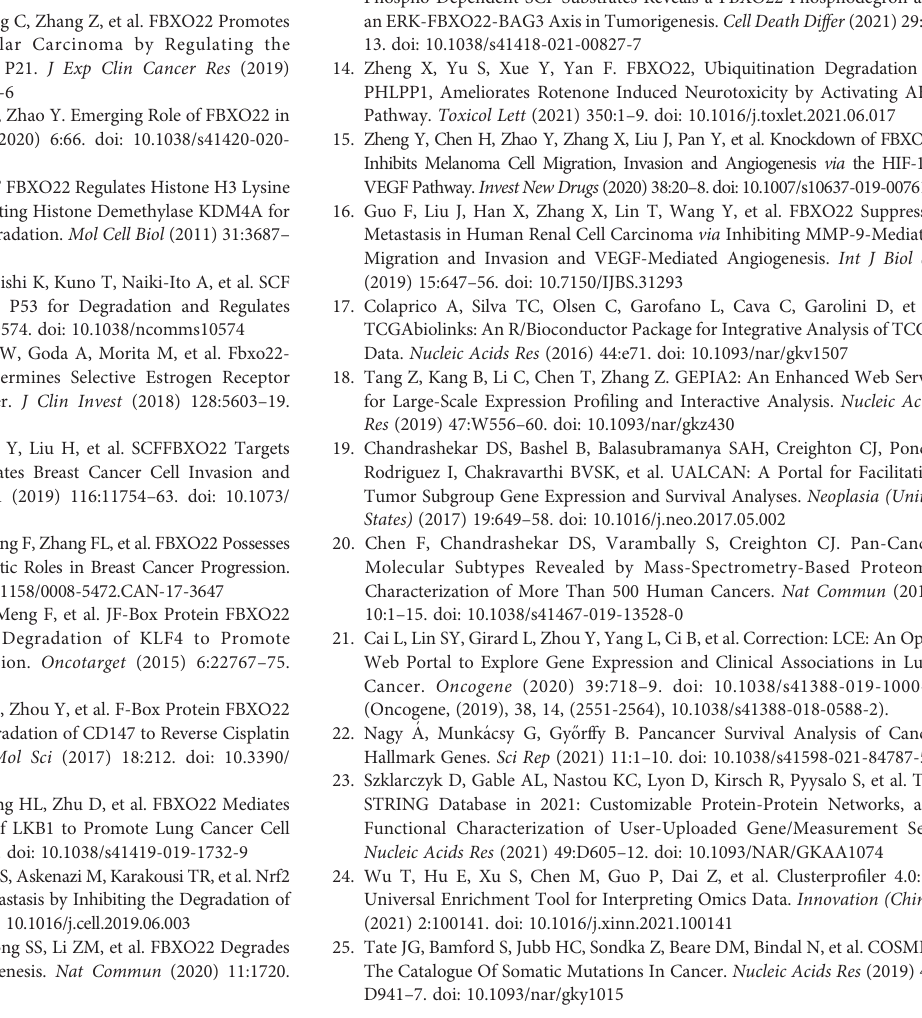
(A) The feature importance score for methylated CpGs in FBXO22 was calculated using the xgboost algorithm in cancers from TCGA. (B) Correlation between overall survival and methylated cg08290738 in CESC and ESCA. (C, D) Correlation between overall survival and methylated cg00942495 and cg05374463 sites in THYM. Supplementary Figure 6 | Spearman correlation heatmap showing the relationship between abundance of tumor-in fi ltrating lymphocytes (TILs) and FBXO22 expression, copy number variation (CNV), and methylation in TISIDB database. Spearman correlations between (A) FBXO22 expression, (B) FBXO22 CNV, and (C) FBXO22 methylation and TIL abundance. Supplementary Figure 7 | Spearman correlation heatmap showing the relationship between FBXO22 expression and, three kinds of immunomodulators, and chemokines. Spearman correlations between expression of FBXO22 and (A) chemokines, (B) receptors, (C) immunoinhibitors, (D) immunostimulators, and (E) major histocompatibility complex components across human cancers. Supplementary Figure 8 | Spearman correlation heatmap showing the relationship between FBXO22 expression and tumor in fi ltrating leukocytes (TILs) based on different algorithms. (A) CIBERSORT-ABS, (B) CIBERSORT, (C) EPIC, (D) TIMER, (E) MCP-counter, (F) quantTIseq, (G) xCell, and (H)